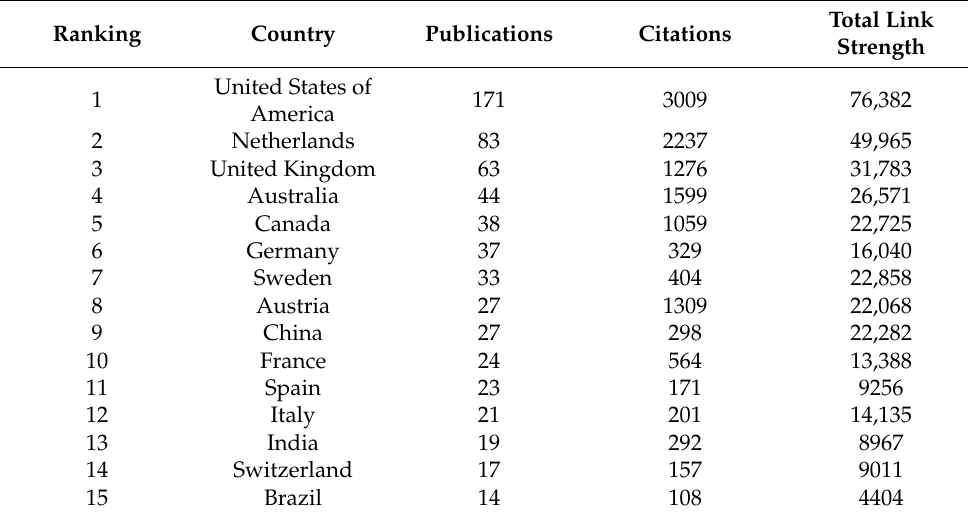
Table 1. Top 15 countries with the highest number of